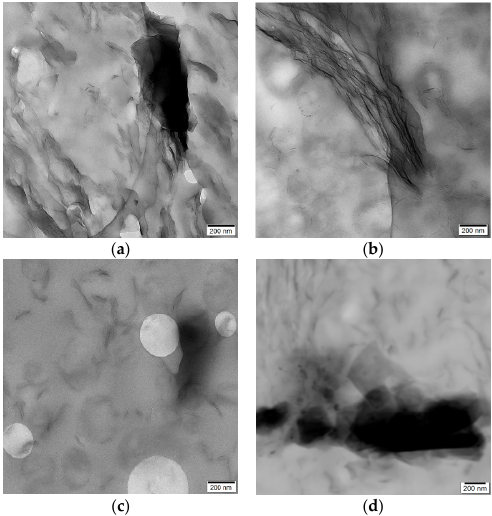
Figure 3. TEM images of ultrathin sections from films based on nanocomposites with 3.0 wt.-% filler: ( a ) CM-3.0-240, ( b ) CM-3.0-270, ( c ) ME-3.0, and ( d ) from granule with 3.0 wt.-% filler before preparation of films.